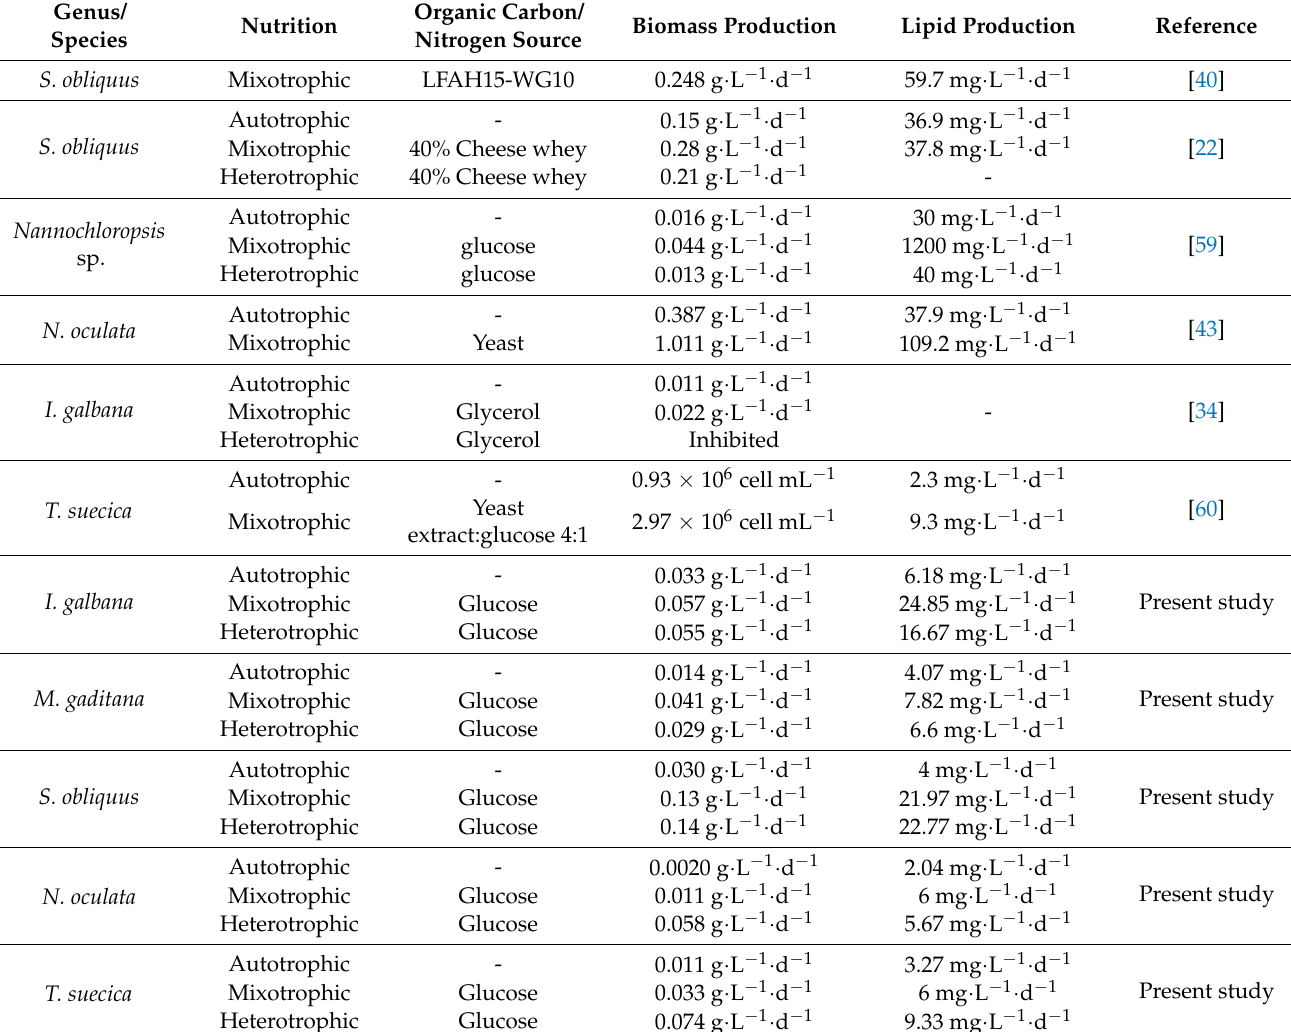
Table 4. Overview of biomass and lipid production from the microalgae of the current